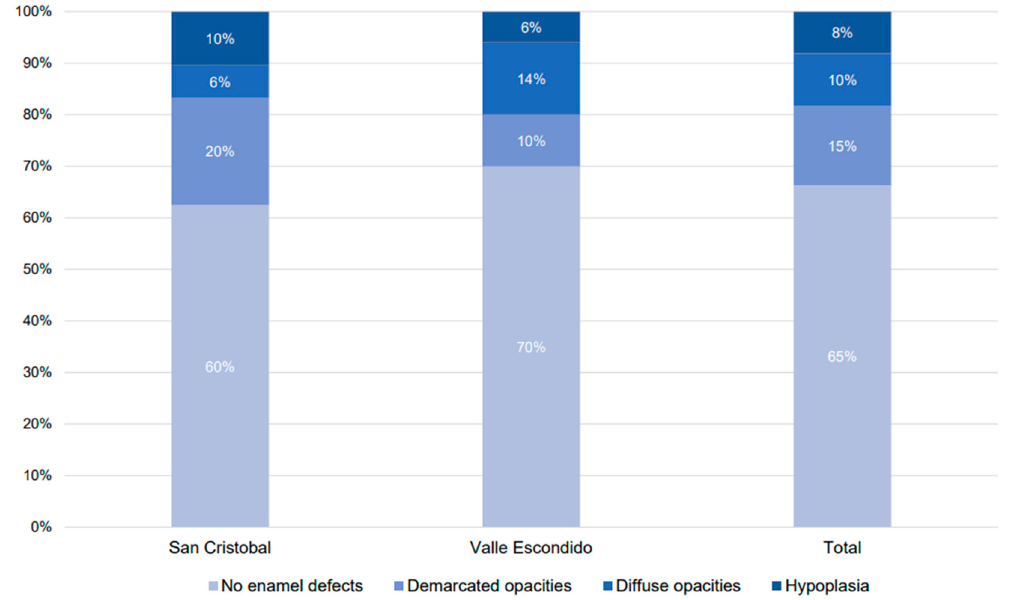
Figure 2. Percentage of teeth with and without developmental defects of enamel.